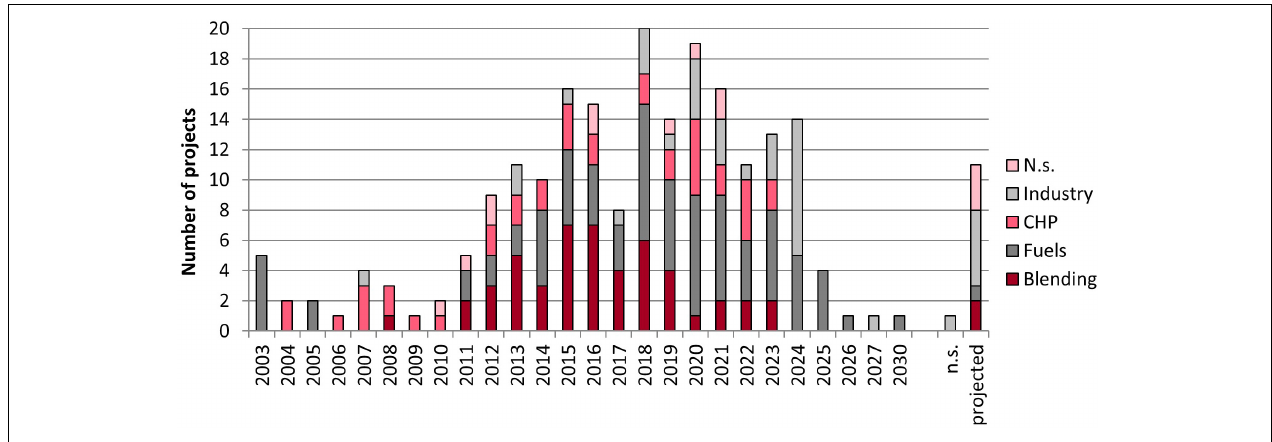
FIGURE 10 | Historical development of Power-to-X projects with regard to fields of application. CHP, combined heat and power, n.s., not specified.